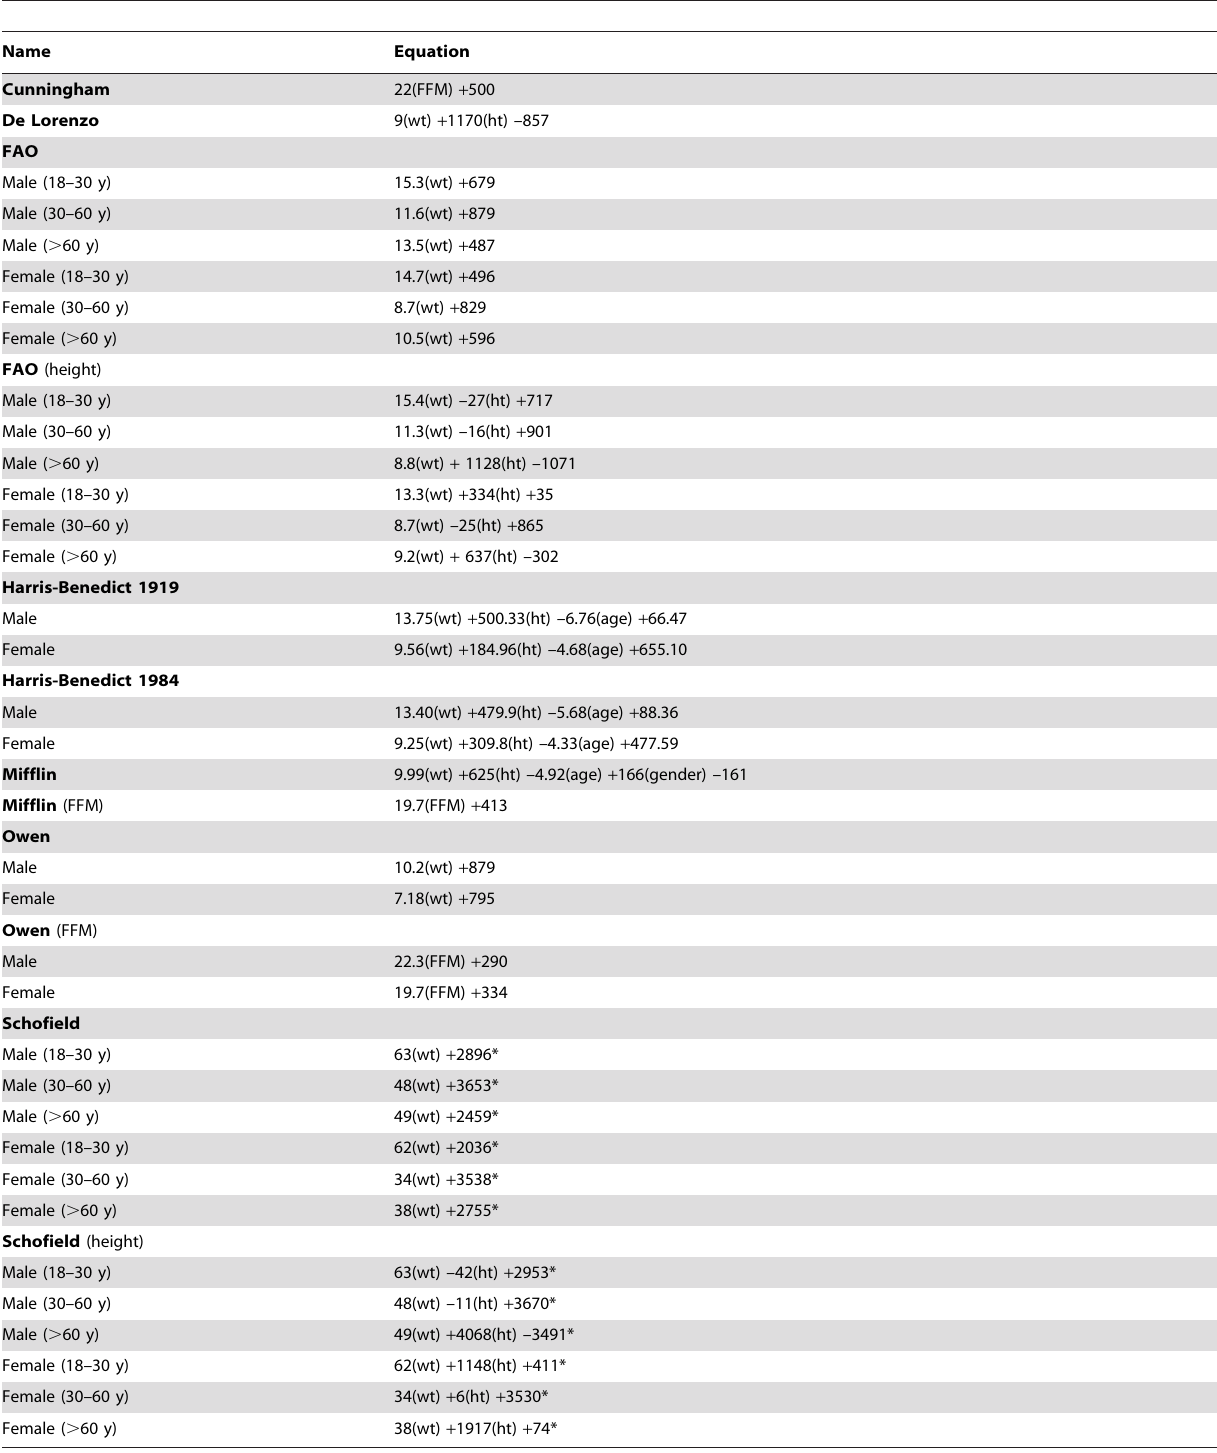
Table 4. Resting energy expenditure prediction equations given in their original unit (kcal/day, except Schofield